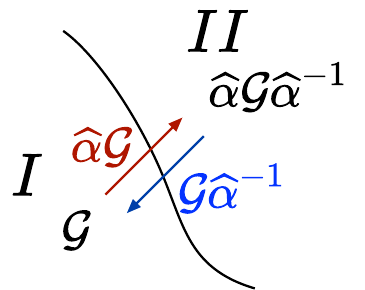
Figure 1. Passing from crystal I of space group G to crystal II of space group (cid:98) α G (cid:98) α − 1 is achieved using any element of the left coset (cid:98) α G ; the inverse transformation from crystal II to I is described by using any element of the right coset G (cid:98) α − 1